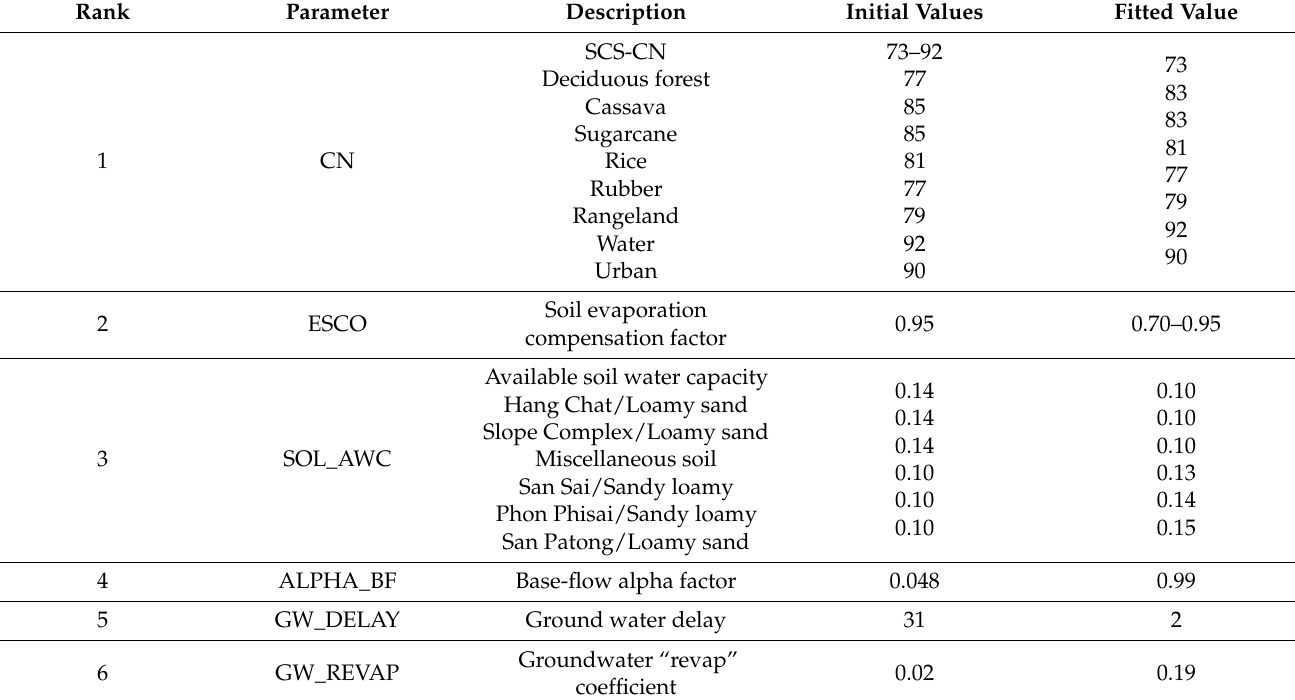
Table 6. Adjusted range of parameters for streamflow calibration and their final values in the Huai Bang Sai River Basin.